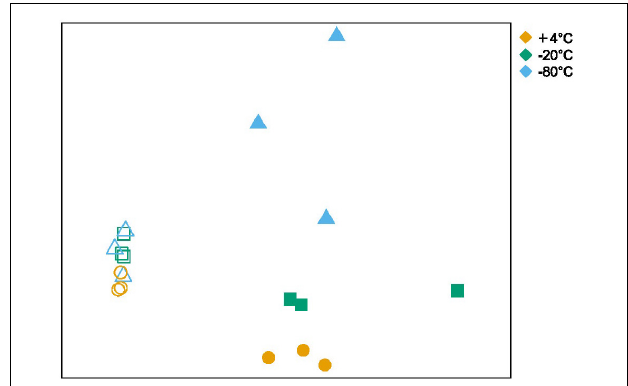
FIGURE 3 | Non-metric multidimensional scaling of bacterial community similarity based on 16S rRNA gene amplicon sequencing, for samples before and after incubation at +50 ◦ C that received +4 ◦ C, –20 or –80 ◦ C freezing pretreatments. Open symbols correspond to microbial communities after pretreatment but before +50 ◦ C incubation, and closed symbols correspond to communities after 7 days of incubation at +50 ◦ C. The stress is 0.076 after 20 iterations. ANOSIM comparing the communities belonging to different pretreatment groups (after-incubation) resulted in an R statistic of 0.42 and a p -value of 0.011 after 999